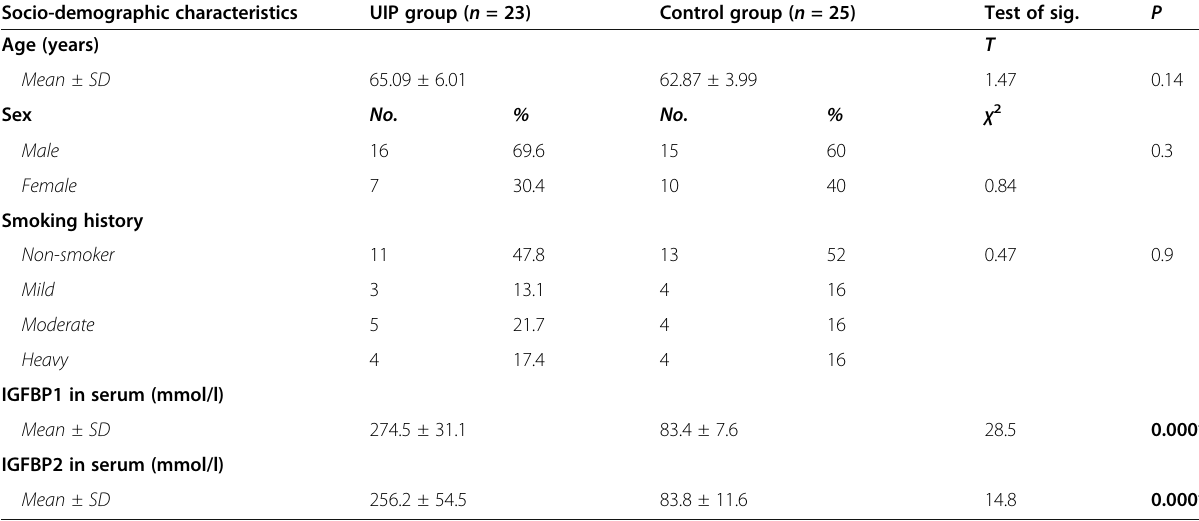
Table 1 Demographic parameters and biomarkers of the UIP group versus control group Socio-demographic